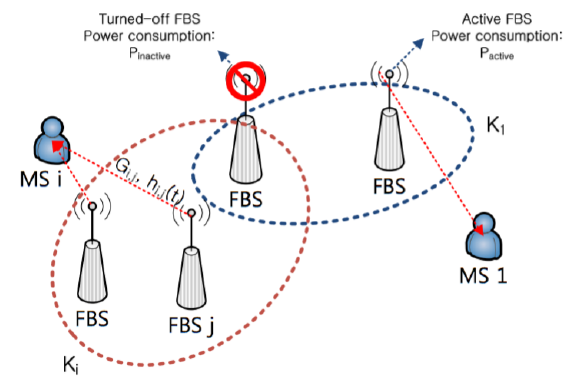
Figure 2. System model which depicts femto-cell base stations (FBSs) with cooperative transmission, MS: mobile